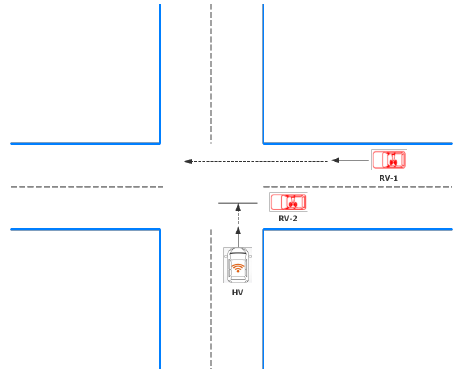
Figure 3. HV and RV drive to the intersection